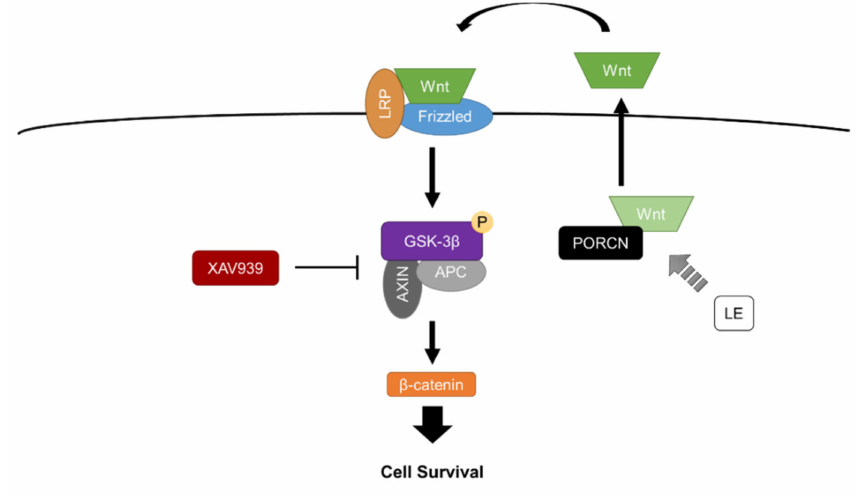
Figure 7. Schematic diagram of the protective mechanism of LE in ischemic reperfusion injury. LE increases the lipid modification of Wnt proteins by PORCN. Lipid-modified / active Wnt proteins are released to the extra-cellular space for the binding to Frizzled / LRP receptors. The activated receptors induce the phosphorylation of GSK-3 β , which prevents the destruction complex from the degradation of β -catenin by proteasomes. Preserved levels of β -catenin lead to cell survival. The injection of XAV939 prevents the phosphorylation of GSK-3 β , which allows β -catenin degradation for